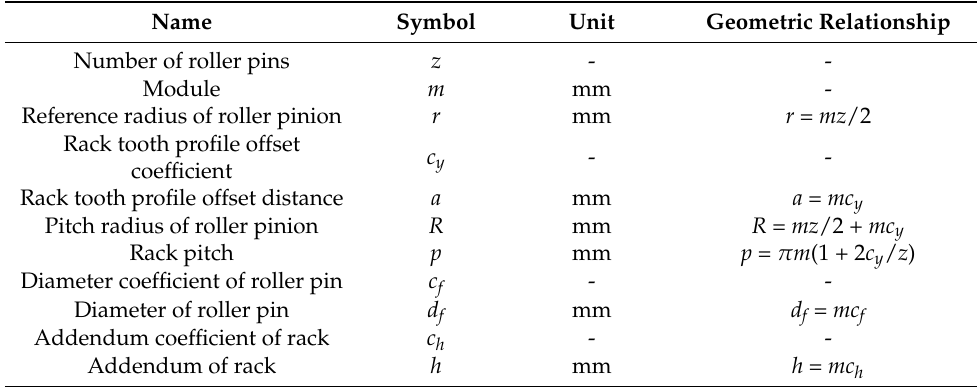
Table 1. Calculation method of parameters of trochoidal roller pinion